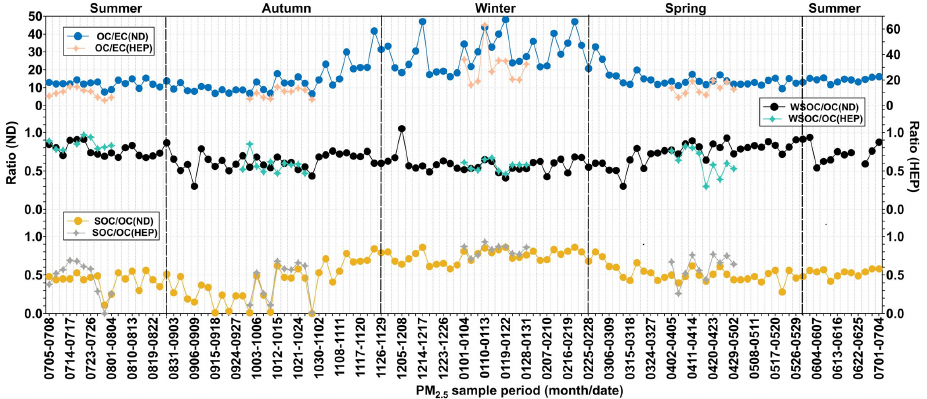
Figure 6. Temporal variations in the ratios of OC / EC, WSOC / OC and SOC / OC in PM 2 . 5 at ND and HEP in Tianjin during 2018–2019. See the text for abbreviations.